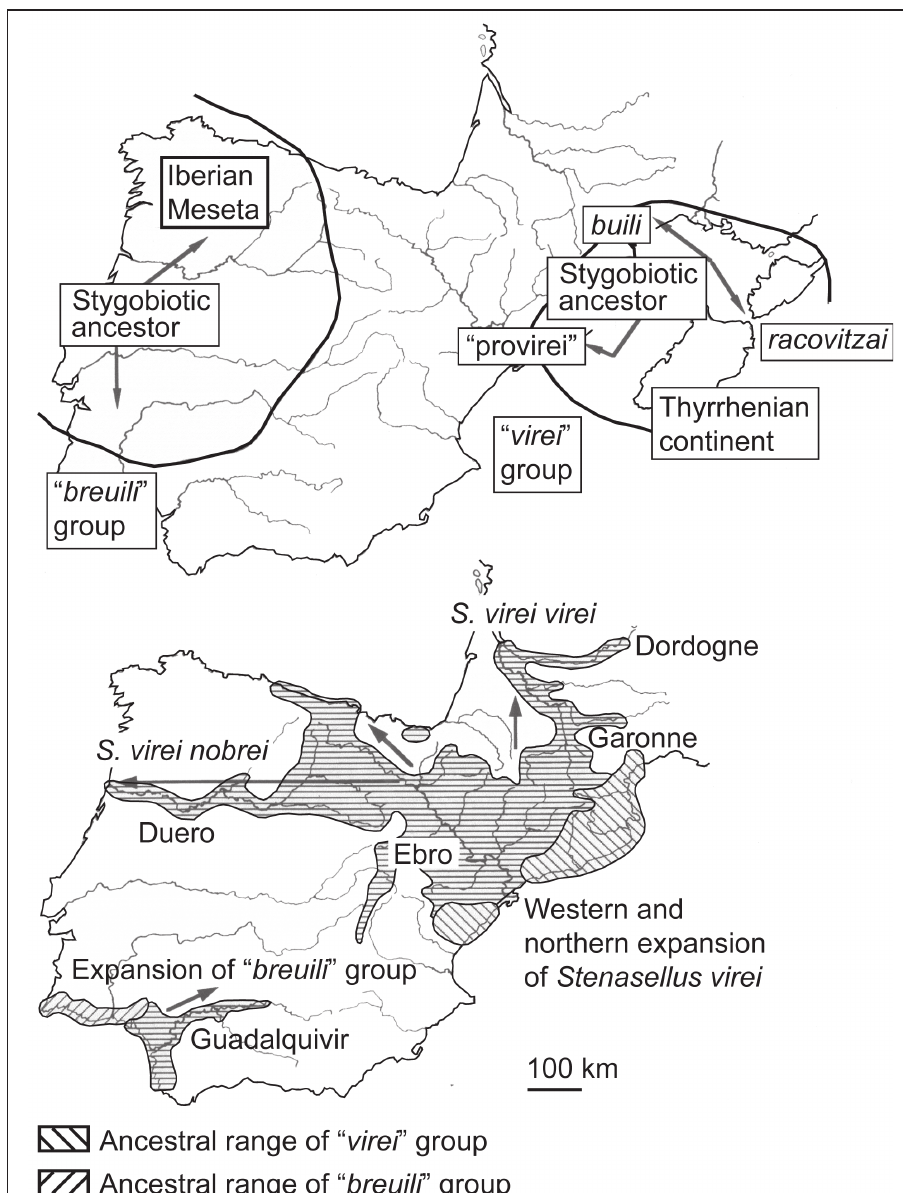
Figure 3. Paleobiogeography of the Ibero-Aquitanian stenasellids. Upper panel. Palaeogeographic con- tinental areas attributed to the stygobiotic ancestors of the “ breuili ” and “ virei ” groups before migration of the Corsica-Sardinia plate. Limits are very approximate. Lower panel. Recent expansion of geographic ranges of the “ breuili ” and “ virei ” groups due to dispersal along large Ibero-Aquitanian river systems. Modified after Magniez